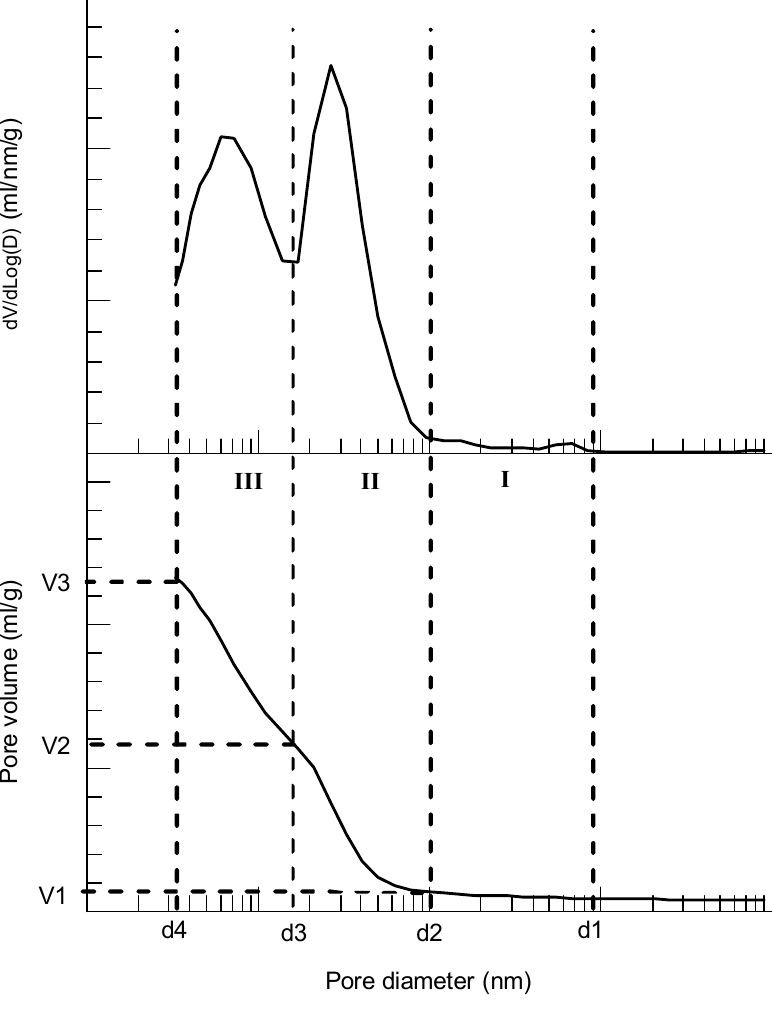
Figure 4. Typical pore distribution of cement paste with three stage divisions. Under insulation curing, see Figure 5b, first, a similar pattern of pore distribution of the cement paste subject to insulation curing is observed compared with that of standard curing. The two-peak mode (derivative curve) and two-stage mode (cumulative curve) is obvious. This similarity indicates the present insulation cover curing performed at very early-age (within 3 days) and does not make and obvious change in the pore structures of the cement paste according to the classification shown in Figure 4. Second, as expected, within the initial three days of insulation curing, the pore volume of the paste is decreased compared with that of the paste under standard curing at the same age. This is consistent with the increase in compressive strength of the concrete after insulation curing. However, at 28 days, the pore volume of the paste subject to insulation curing is increased a little compared with that of standard curing. The total pore volume at 28 days is 0.2530,